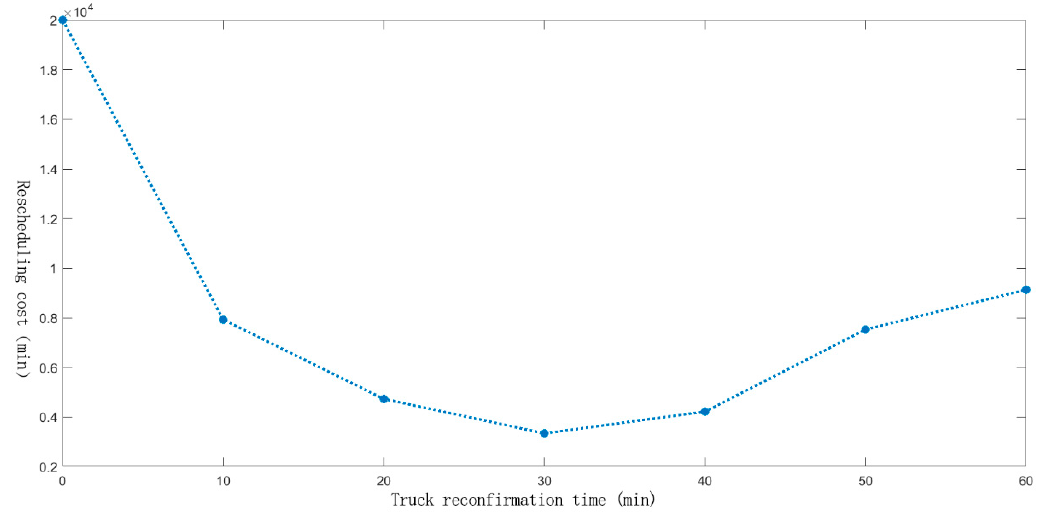
Figure 8. The influence of truck reconfirmation time on the cost of rescheduling.